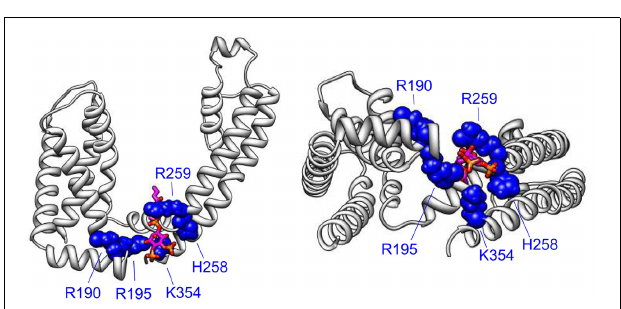
FIGURE 4 | The VSD-PGD interface site. Side view (left) and bottom view (right) of a single KCNQ1 subunit from a homology model (Smith et al., 2007), which was built of the template of the Kv1.2 crystal structure (Long et al., 2005). PIP 2 molecule (magenta, orange, and red) is positioned by aligning the Kir2.2-PIP 2 crystal structure (Hansen et al., 2011) as done previously (Zaydman et al., 2013). Important residues for PIP 2 -dependent coupling are shown. Note that some additional residues reside in more C-terminal regions that are not represented in the homology model due to a lack of a structural template for the KCNQ